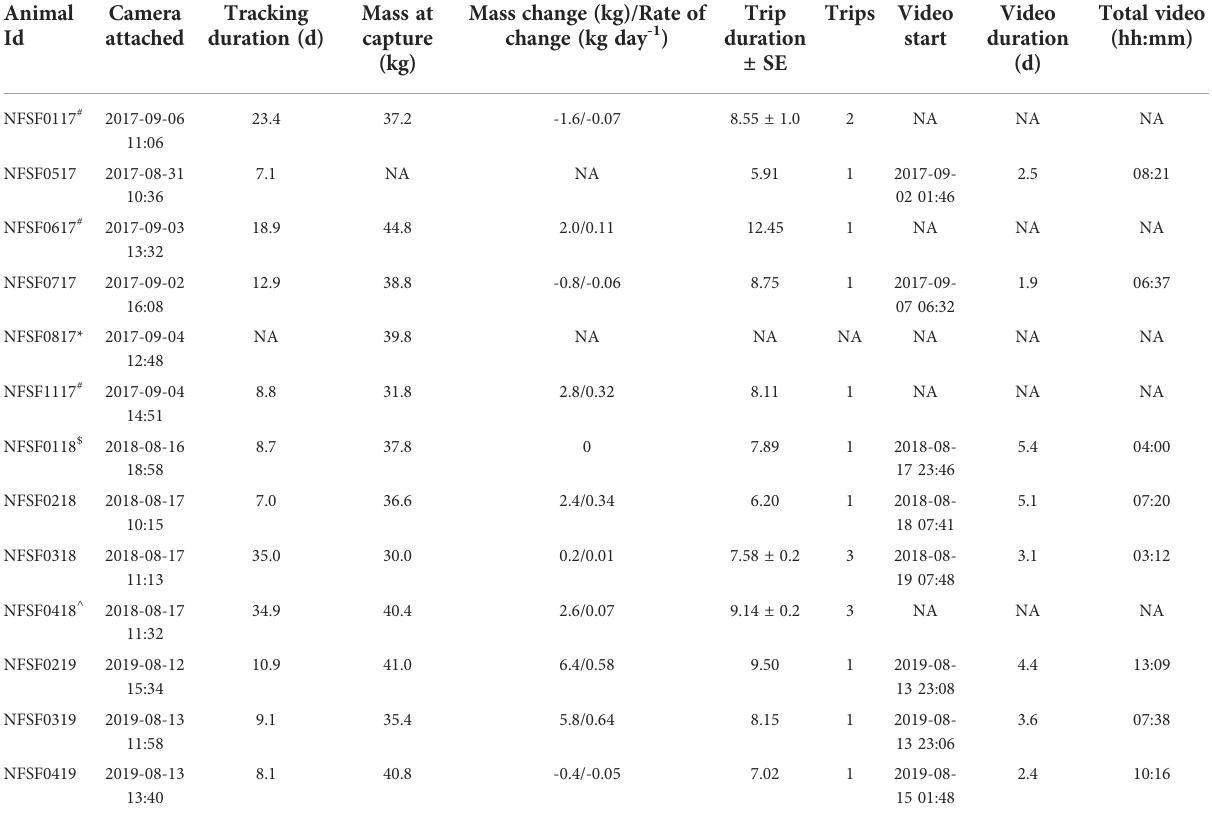
TABLE 1 Summary of tracking information and mass characteristics for 13 northern fur seals equipped with video cameras in 2017, 2018, and 2019. Animal Camera Id attached